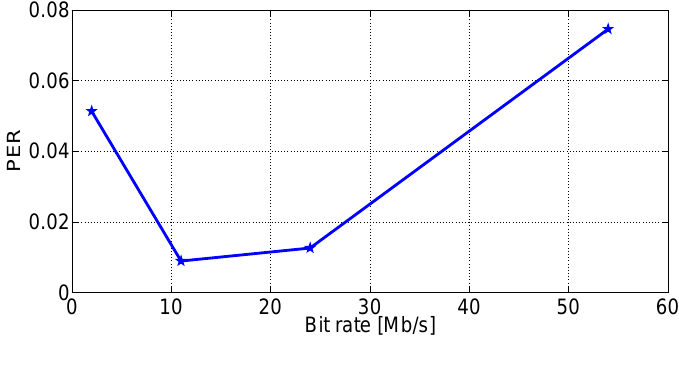
Figure 7. Experimental Packet Error Rate (PER) as a function of the data rate, by considering P = 32 mW and d = 15 m t